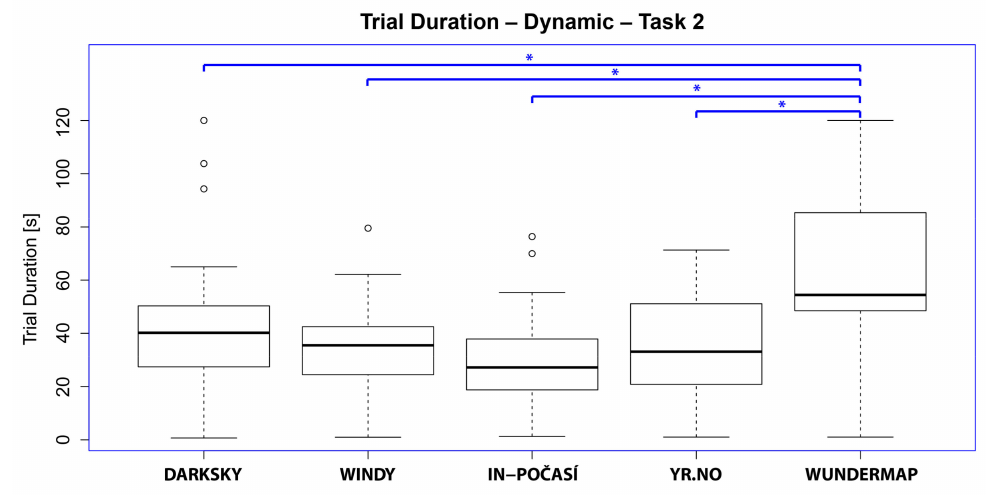
Figure 11. Trial Duration to find the answer in the Dynamic Section—Task 2.